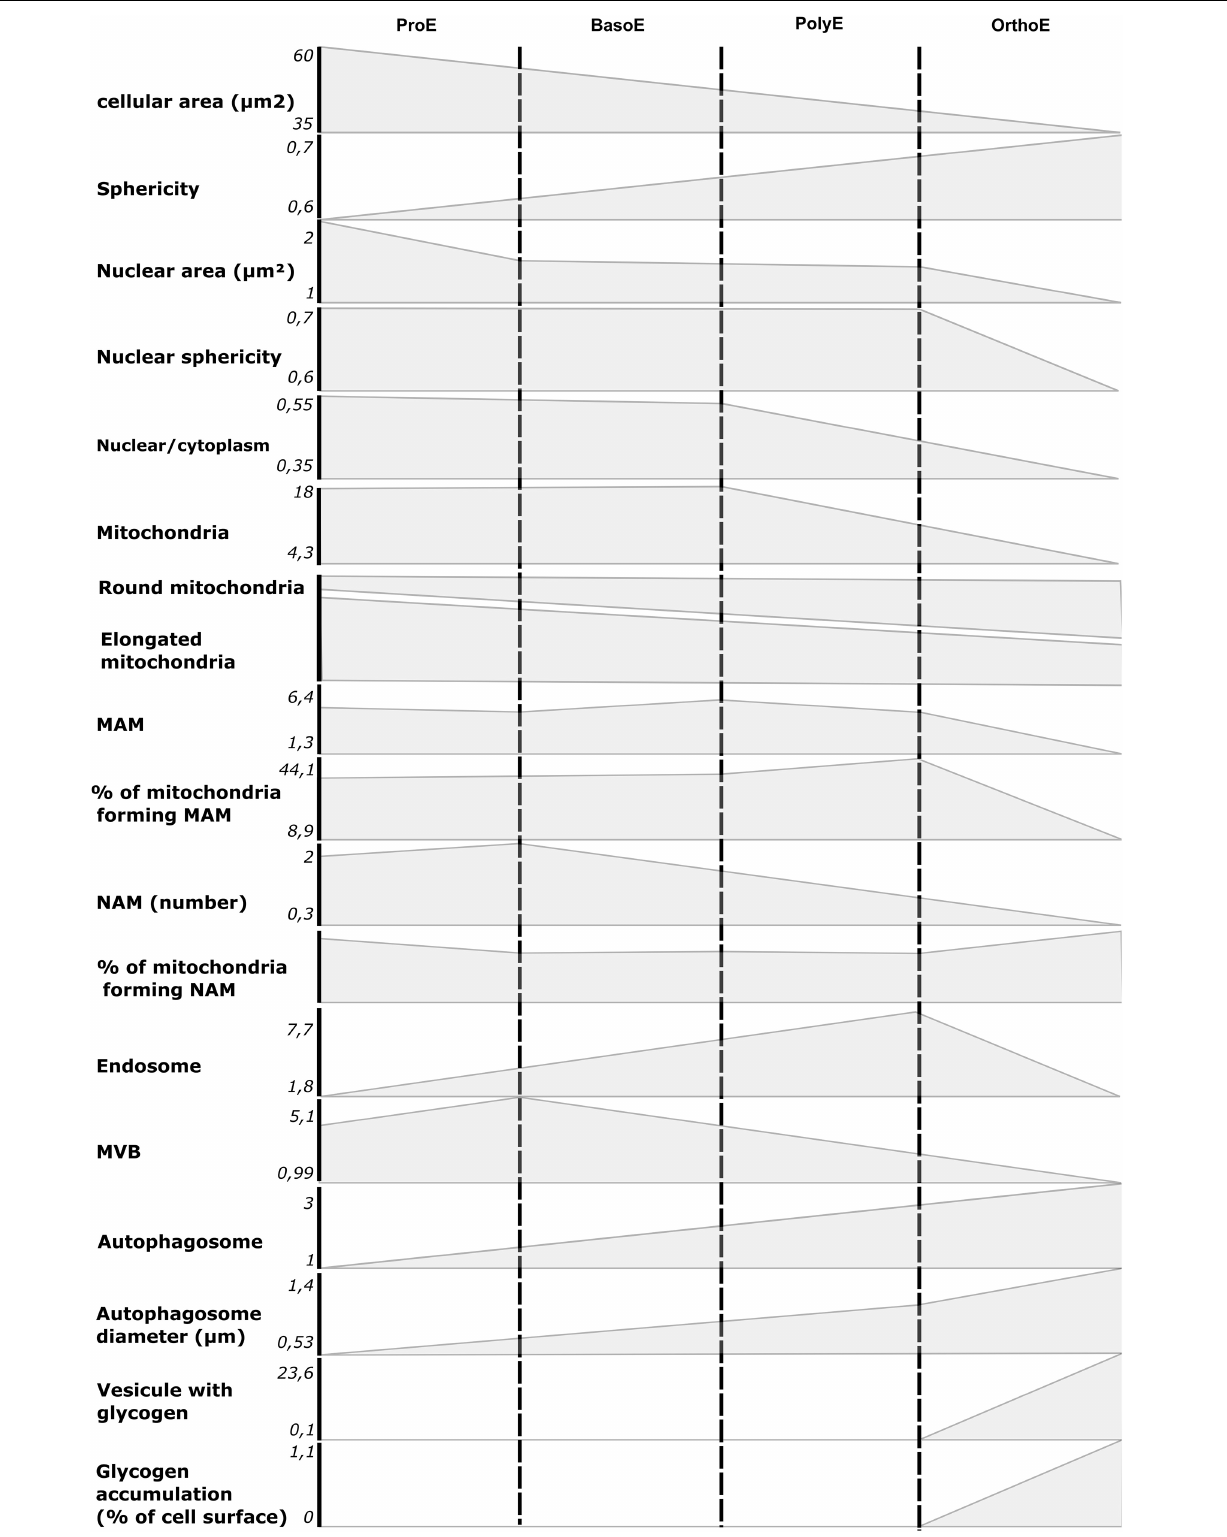
Frontiers in Physiology |